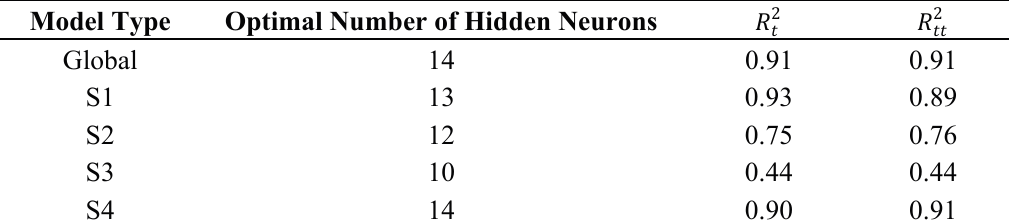
Table 7. Neuroet modeling of R n for four